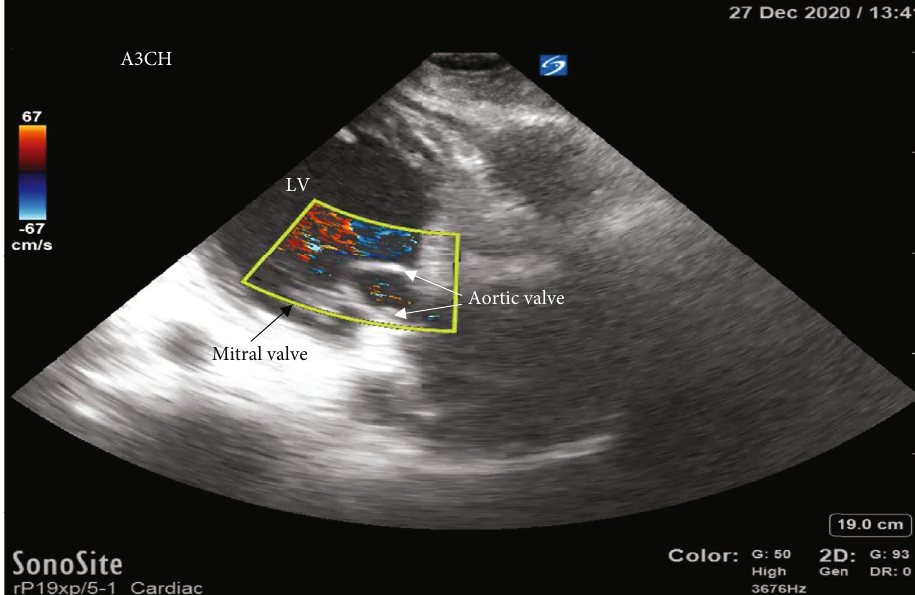
Figure 6: Color fl ow Doppler demonstrating regurgitant fl ow through the aortic valve, which has retracted back into the left ventricle because of the aortic root